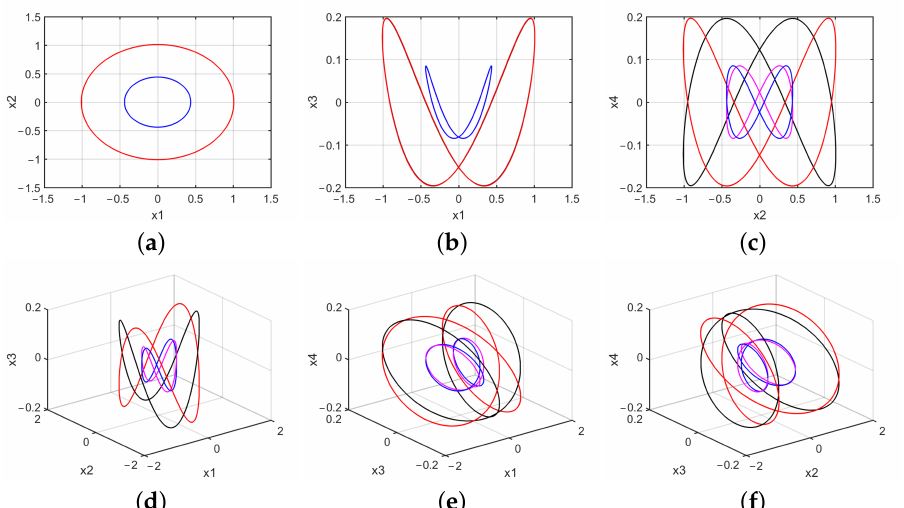
Figure 7. Morphology and relative positions of four periodic solutions when f 1 = 13 > f 12 : ( a ) ( x ) plane; ( b ) ( x ) plane; ( c ) ( x 1 , x 2 1 , x 3 ( x ) space. 2 , x 3 , x 4